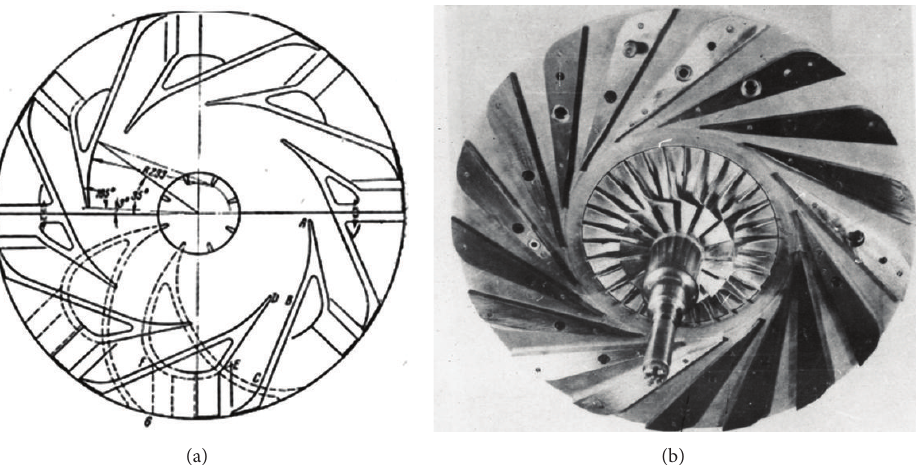
Figure1:Channeldiffusersoftraditionalgeometry:(a)channeldiffuserwithinitialsectionshapedasalogarithmicspiral,(b)channeldiffuser with wedge vanes.